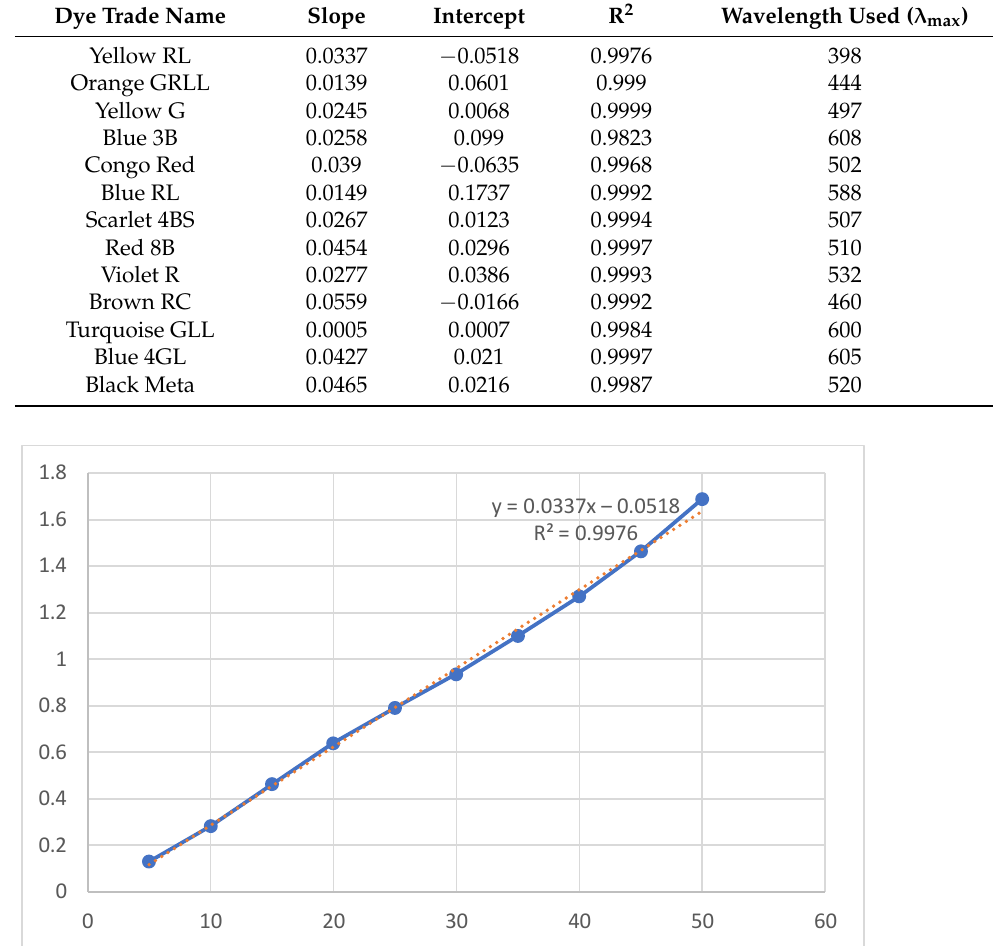
Figure 4. Calibration curve of Yellow RL dye (5 – 50) mg/L, pH 7, 25 °C.